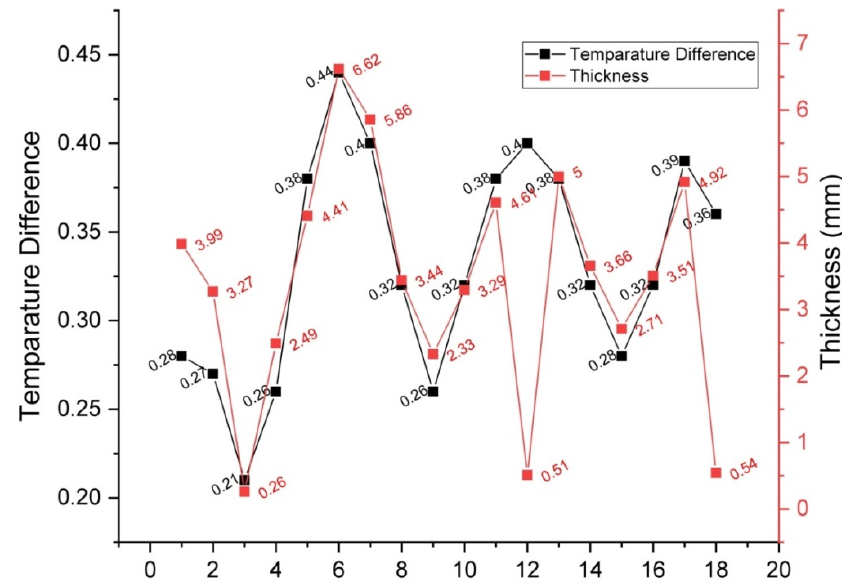
Figure 7. Change of temperature difference according to object thickness.